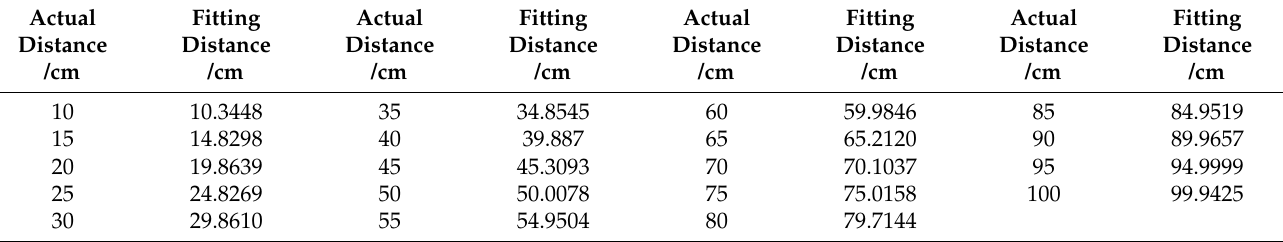
Table 4. Actual distance and fitted